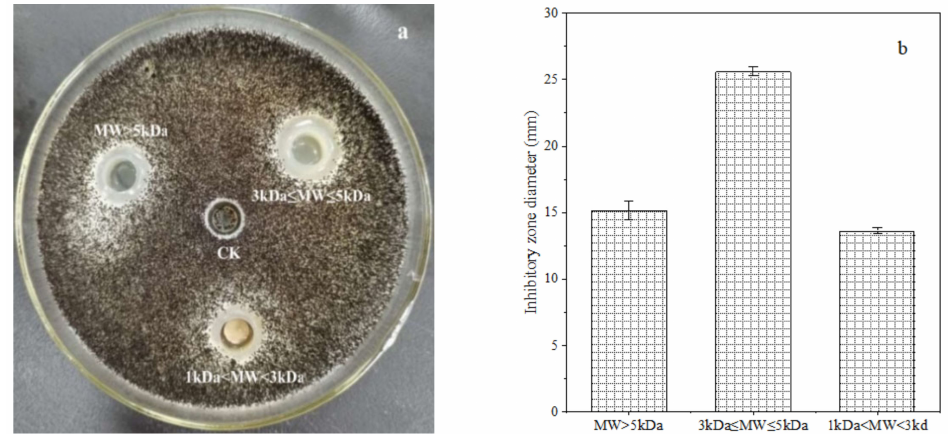
Figure 1. Inhibition effect of polypeptides (at a concentration of 0.5 mg/L) with different molecular weight (0.5 mg/L) produced by B. brevis DTM05 on A. carbonarius H9 ( a ). The inhibition zone diameter of polypeptides with different molecular weight on A. carbonarius H9 ( b